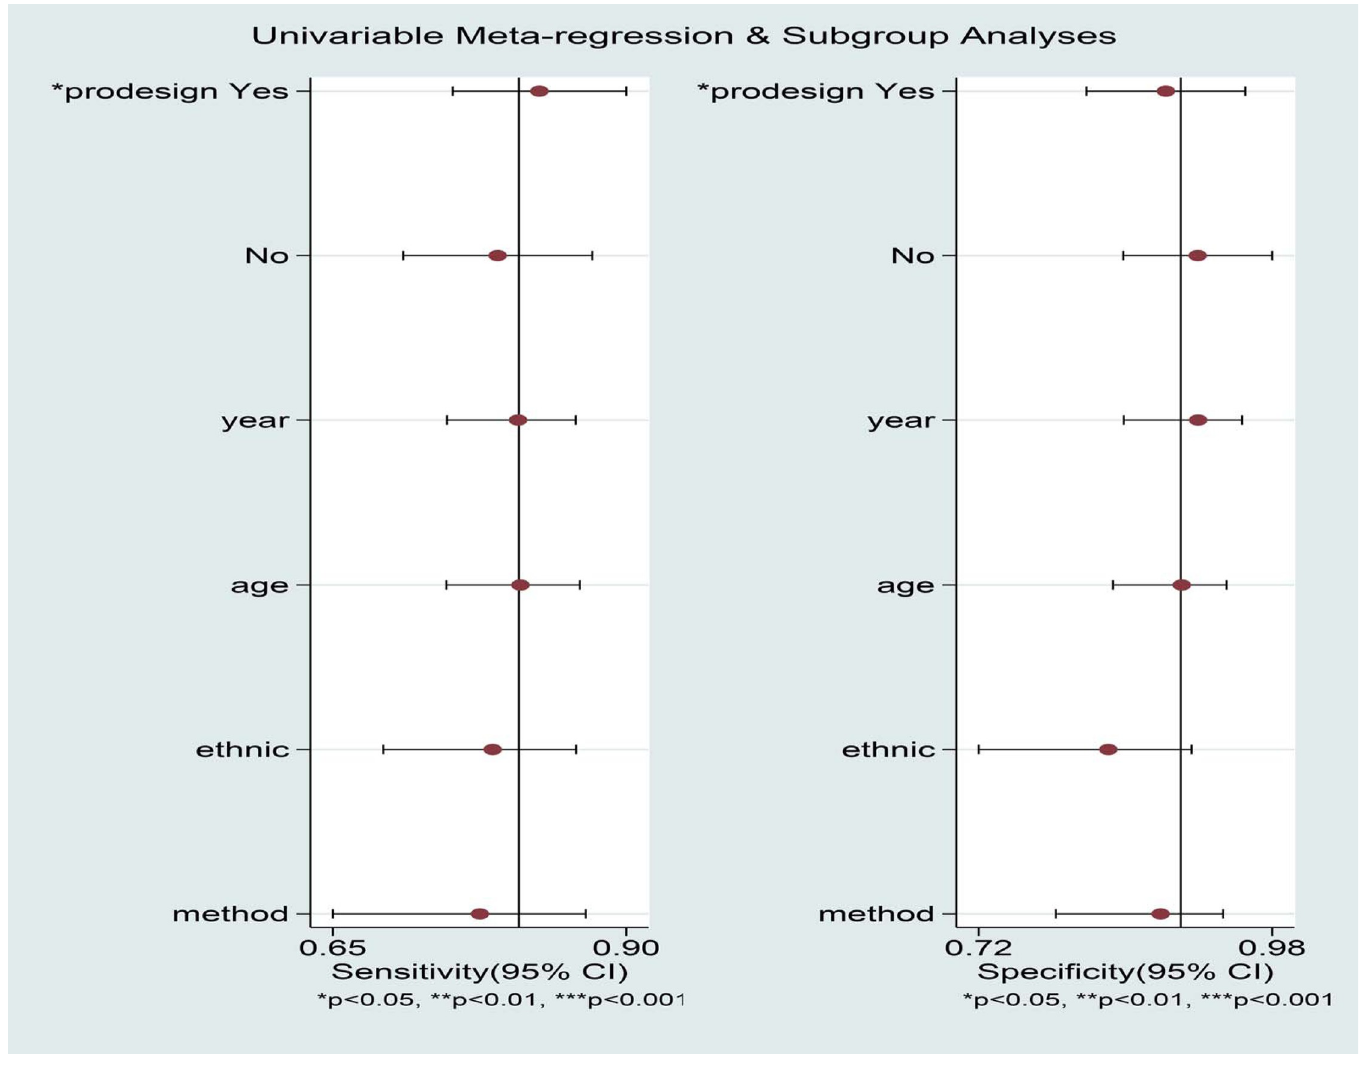
Fig 6. meta-regression analyses for